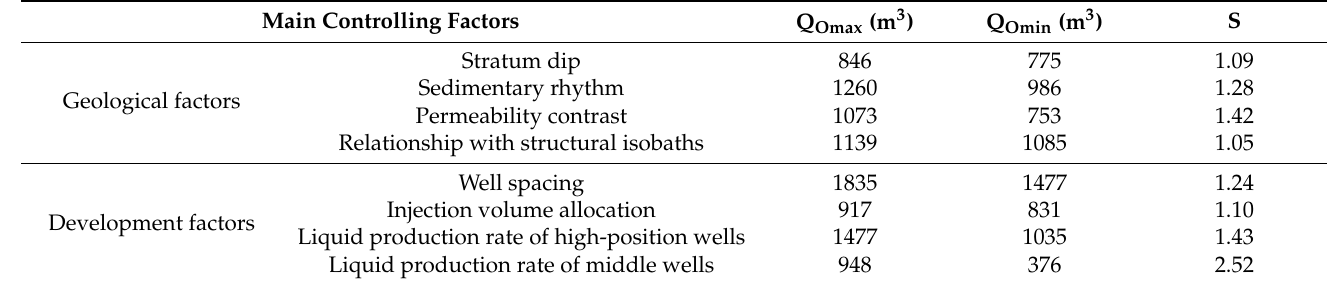
Table 9. Oil increment and sensitivity of each